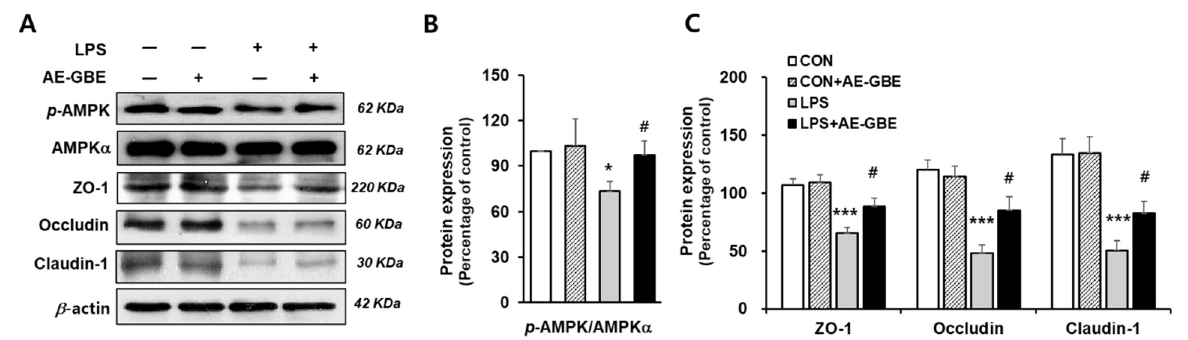
Figure 4. Effects of AE-GBE on AMPK activation and TJ-related proteins in LPS-induced Caco-2 cells. AMPK α , p -AMPK, and tight-junction protein (ZO-1, occludin, and claudin-1) expressions in Caco-2 cells were determined via Western blotting ( A ) and quantified ( B , C ). The data in the figures represent mean ± S.D. *: p < 0.05 and ***: p < 0.001 versus the CON group; #: p < 0.05 compared with the LPS alone group, n = 3–5.